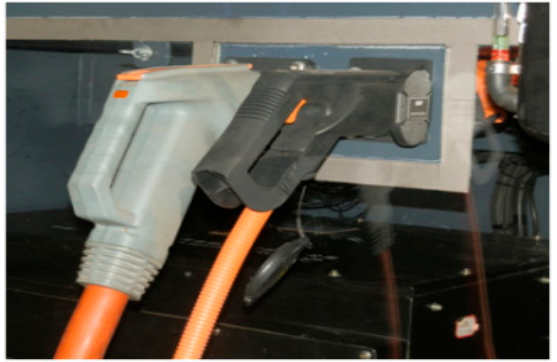
Figure 17. Charging plug ( left ) and heating plug ( right ).